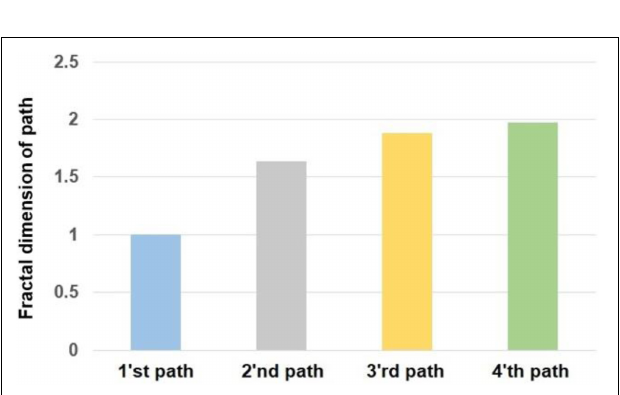
FIGURE 3 | The fractal exponent of heart rate variability. Error bars indicate the SD.